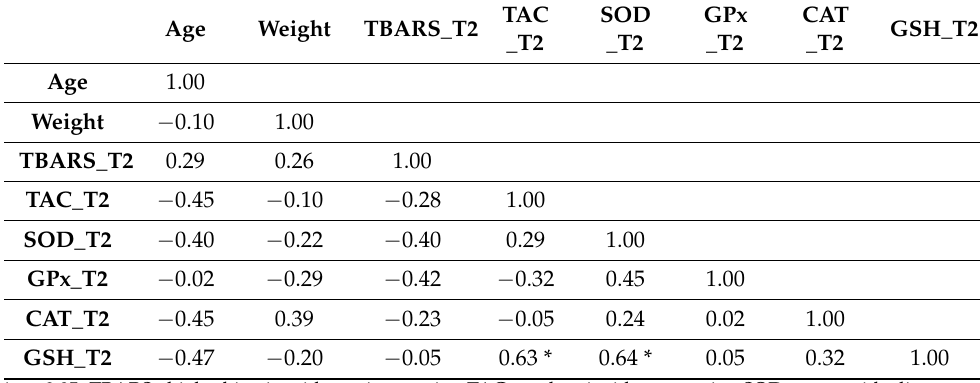
Table 3. Spearman coefficients with correlation matrix.